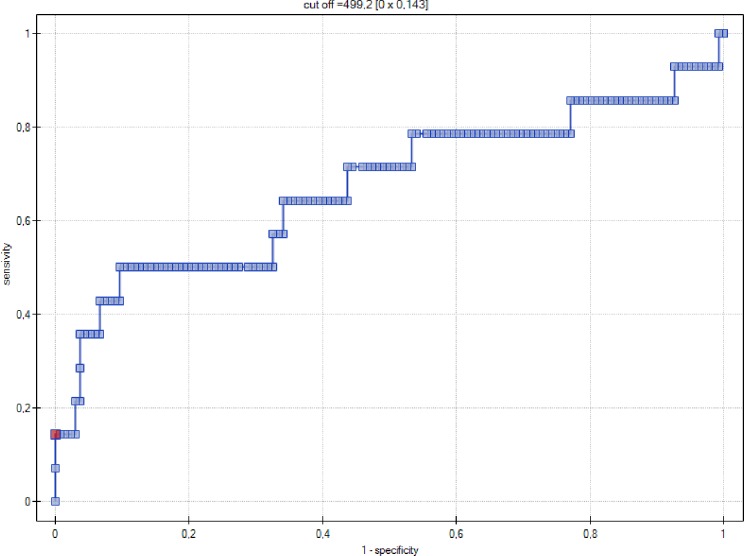
ROC curve–relationship between NT-proBNP levels (pg/ml) and occurrence of preeclampsia.